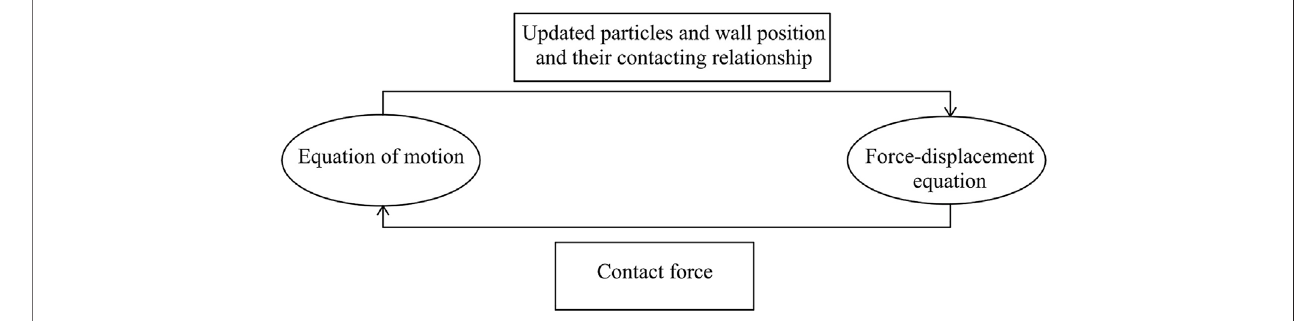
FIGURE 4 | Principle of PFC.